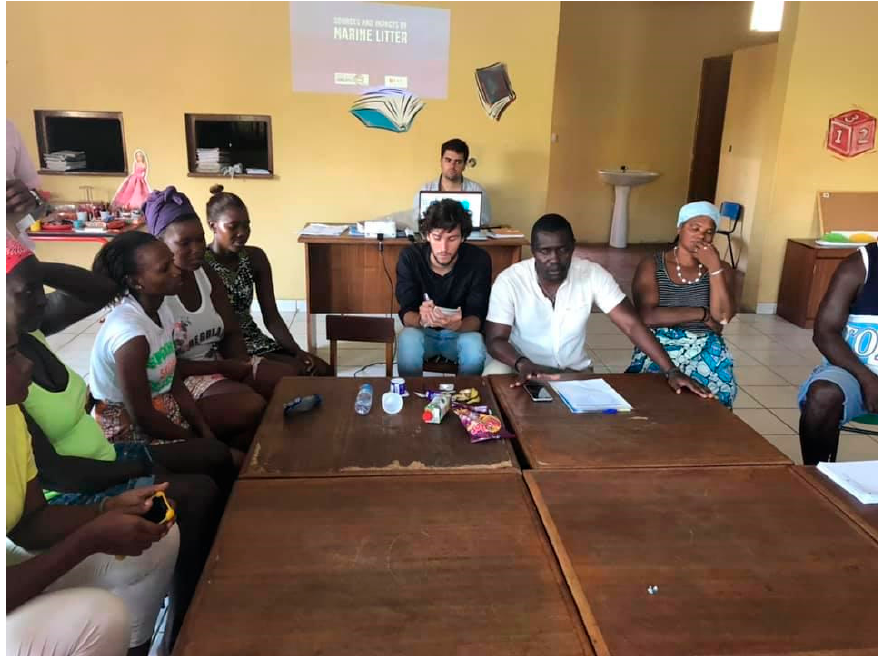
Figure A3. Active listening and brainstorming in the participatory session in Porto Gouveia. (photos by the authors, September 2019).